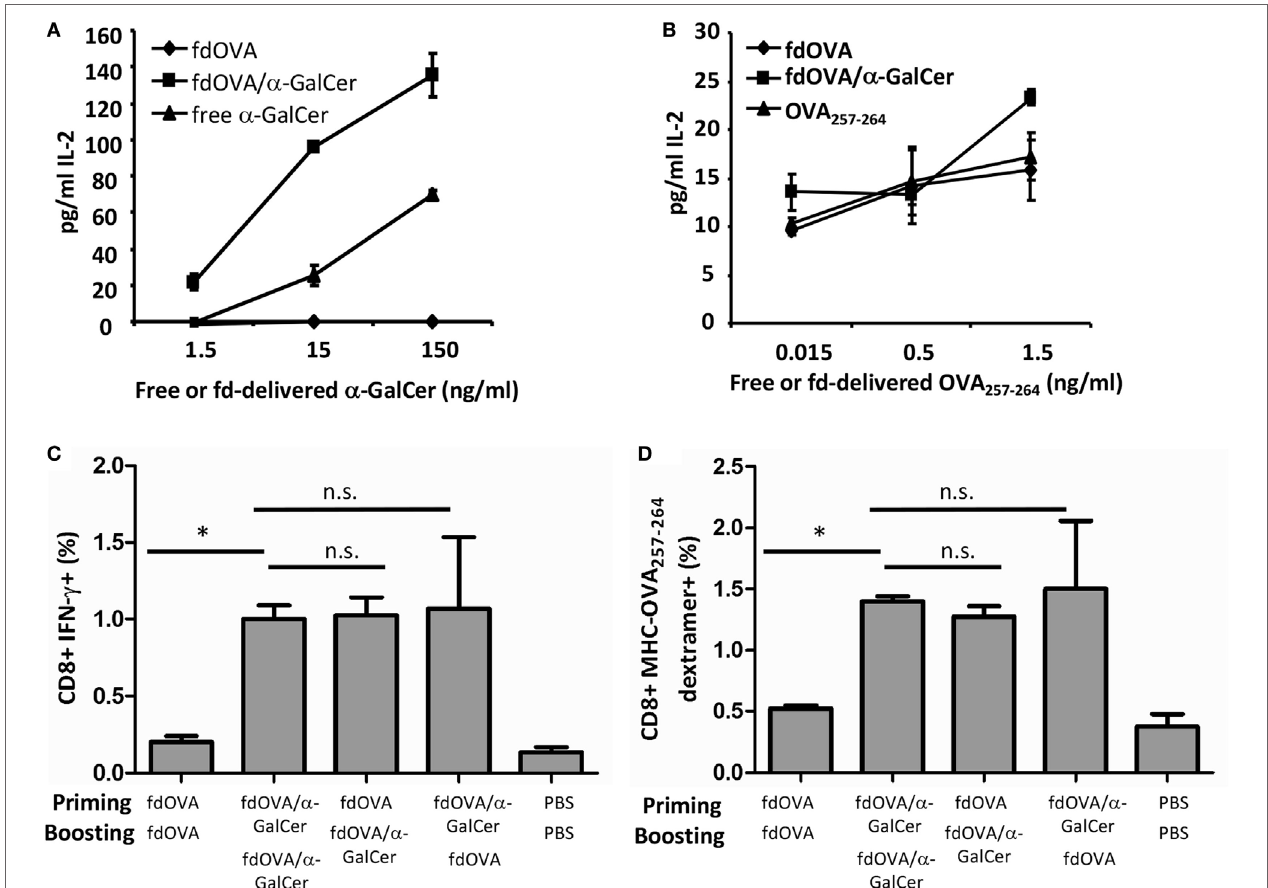
FigUre 3 | Adjuvant effect of vectorized delivery of alpha-GalactosylCeramide ( α -GalCer) on bacteriophages in antigen-specific adaptive immune response. IL-2 release of mouse V α 14 invariant natural killer T hybridoma cell line FF13 (a) or OTI hybridoma cell line (B) in response to α -GalCer or OVA SIINFEKL peptide delivered by phage particles. LPS-free fdOVA filamentous bacteriophages were conjugated to α -GalCer, and fdOVA or fdOVA/ α -GalCer were presented by mouse bone marrow-derived dendritic cells to stimulate FF13 or OTI hybridoma cells. Soluble form of α -GalCer was used as positive control in (a) . Synthetic OVA 257–264 peptide was used as positive control in (B) . Supernatants were diluted 1:10 (a) or left undiluted (B) and assayed in duplicate. Mean ± SD is reported, one representative experiment of two is shown. (c,D) Group of mice ( n = 4/group) were primed (day 0) and boosted (day 14) with fdOVA (SIINFEKL peptide) bacteriophages delivering or not the α -GalCer as indicated on the x -axis. As control, mice were inoculated twice with vehicle alone (phosphate buffered saline, PBS). At day 21, splenocytes were isolated and percentage of OVA 257–264 -specific CD8 + T cells producing IFN- γ (c) and percentage of H2Kb-SIINFEKL dextramer positive CD8 + T cells (D) were evaluated. Average + SEM is reported. Difference were statistical significant by one-way analysis of variance followed by a Dunnett’s multiple comparison test. * p < 0.05. Abbreviation: ns, not